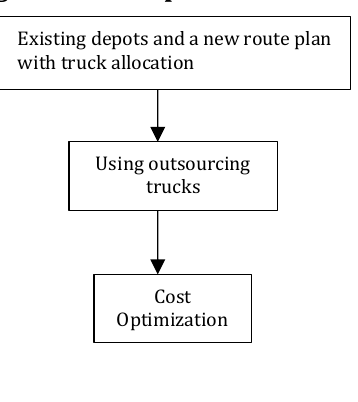
Figure 1: Conceptual frame